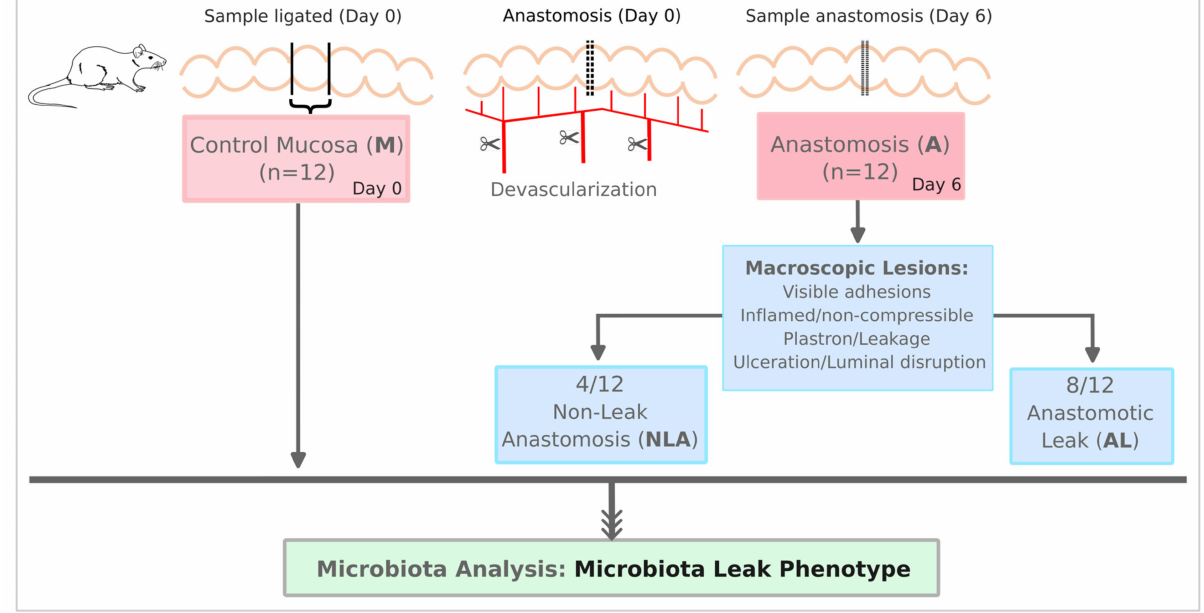
Figure 1. Grouping scheme of rats subjected to anastomosis and